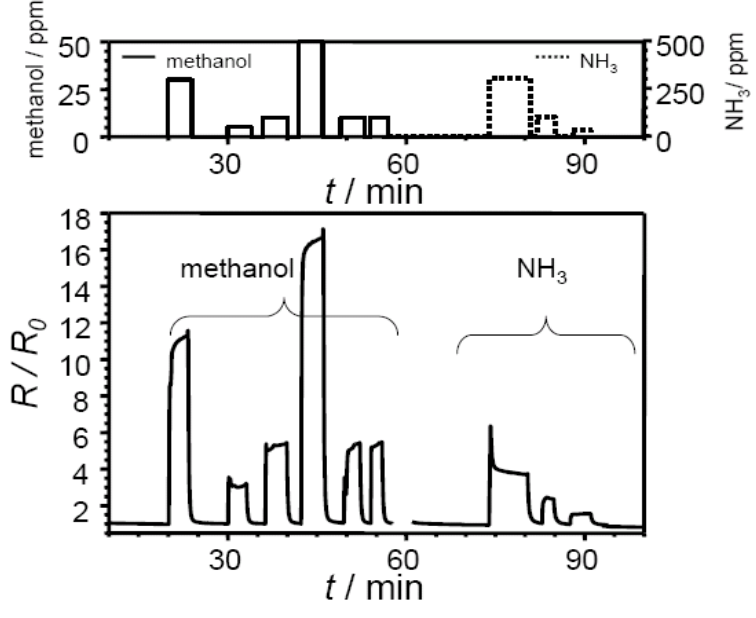
Figure 3. Sensor response of a SrTi gases at 400 °C (concentration as indicated, balance: dry air).